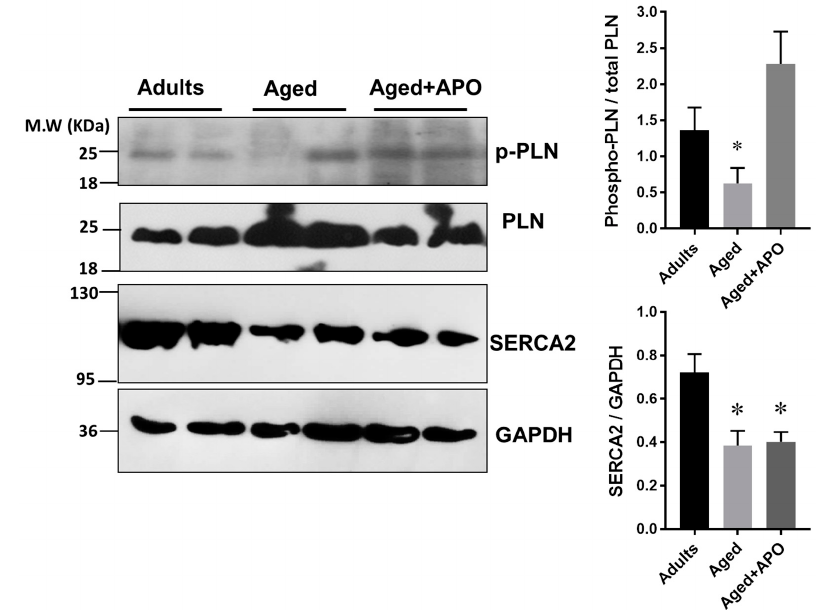
Figure 7. Calcium handling proteins. Left, representative images of Western blots for phospho- phospholamban pPLN (Ser16/Thr17), total phospholamban, and SERCA2 and, from adult, aged, and aged hearts treated with apocynin (APO, 100 µmol/L), all previously challenged with isoproterenol 100 µmol/L. The graphs to the right depict the densitometry analysis (mean ± standard deviation), normalized to GAPDH levels. N = 4 hearts in each group for phospholamban analysis. N = 4 adults and n = 6 in aged and aged + APO for SERCA analysis. * p < 0.05 vs. adults.